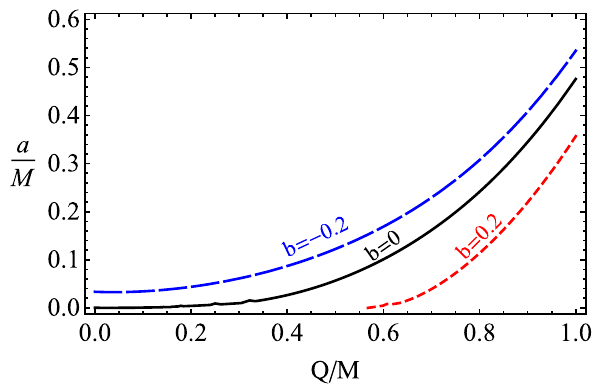
Fig. 8 Relation between degeneracy values of spin parameter of the rotating Kerr black hole and magnetic charge of RN black hole which provides the same values of the ISCO radius for the fixed values of the parameter β = 5 , 10 , 15.